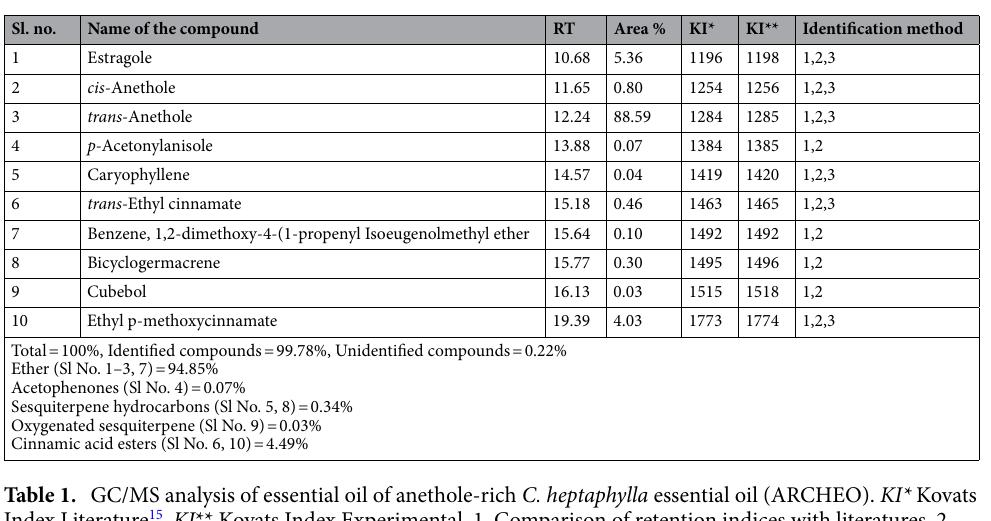
Table 1. GC/MS analysis of essential oil of anethole-rich C. heptaphylla essential oil (ARCHEO). KI* Kovats Index Literature 15 , KI ** Kovats Index Experimental, 1. Comparison of retention indices with literatures, 2. Comparison of the mass spectra with the mass libraries, 3. Comparing retention time with standards injected with same GC